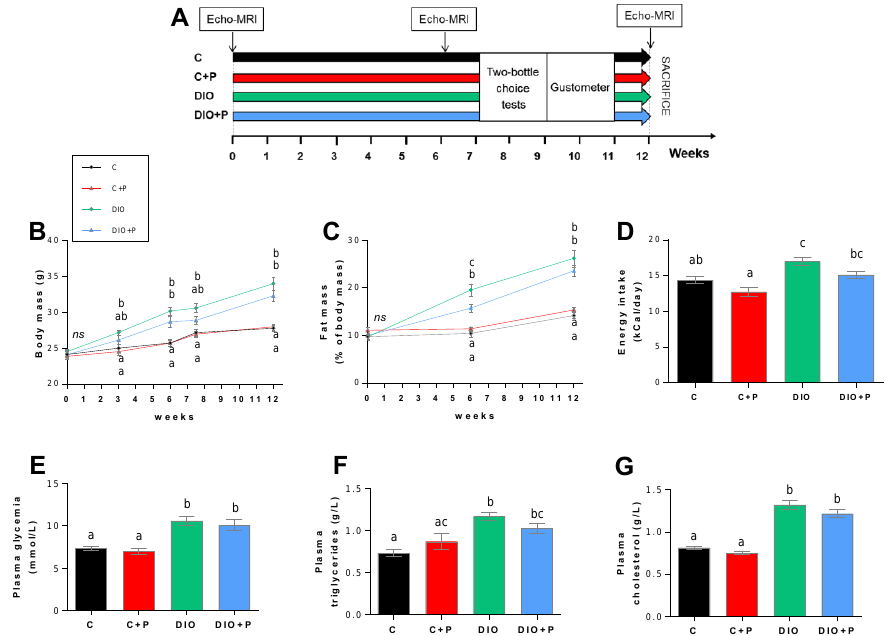
Figure 1. Comparison of body and biochemical parameters in mice subjected for 12 weeks to a regulatory chow or an obesogenic diet alone (C and DIO) or supplemented with 10% Prebiotic (C+P and DIO+P). ( A ) Time course of the experiment; ( B , C ) Evolution of the body and fat; ( D ) Daily energy intake; ( E ) Blood glucose; ( F , G ) Plasma triglyceride and cholesterol levels. Mean ± SEM, different letters indicate a statistical difference between groups. Significance was achieved at p < 0.05. C, C+P, DIO, n = 10. DIO+P, n =